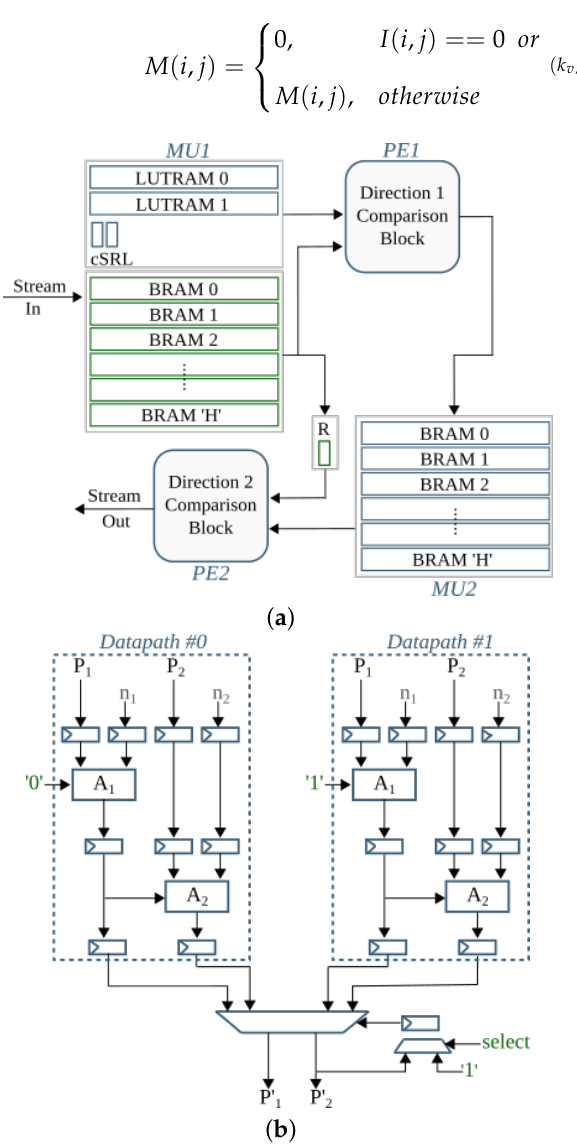
Figure 19. ( a ) hardware architecture of the alternate hole-fill algorithm. MU1 and MU2 are the memory units and PE1 and PE2 are the processing engines. ( b ) Datapath optimization. Here, ( P ) are input pixels read together, ( n 1 , P 2 corresponding output pixels. Select is used to input ‘1’ for every set of pixels that start exactly at the boundary of the